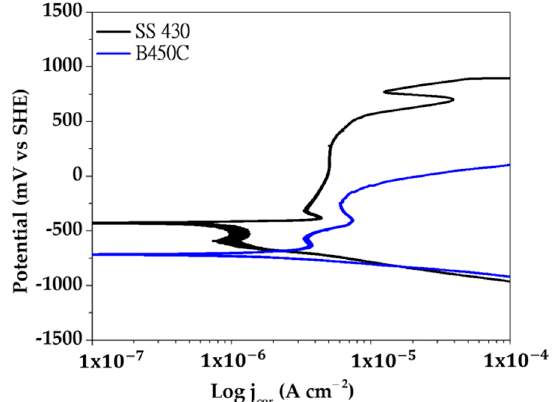
Figure 7. Potentiodynamic polarization curves of SS 430 stainless steel and B450C carbon steel exposed to the cement extract solution (+5.0 g L − 1 NaCl).